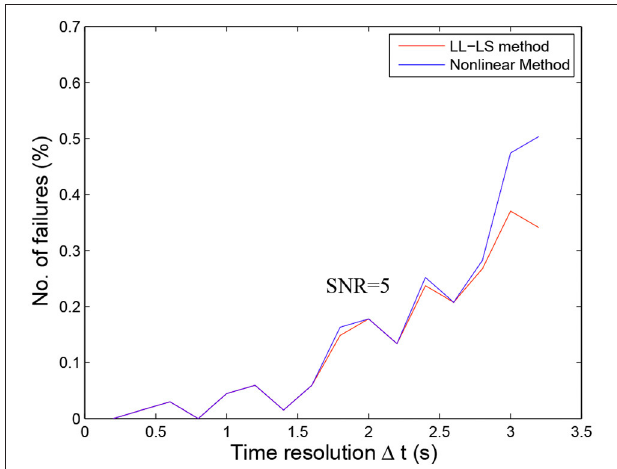
FIGURE 5 | Failures of the fitting procedure with the LL-LS and nonlinear methods as functions of the time resolution ( 1 t ) for SNR 5. The fitting = procedure was considered to have failed if the algorithms did not converge or the calculated values of parameters α and β were imaginary numbers. The α , β estimated parameter obtained using the LL-LS method is used as the { } initial value in the nonlinear fitting procedure. The number of failures of the nonlinear method is thus equal to the number of failures of the LL-LS method plus the number of times that the algorithm for the nonlinear diverged. The number of failures consistently increased as the time resolution decreased. However, there were no failures for the proposed method even for the highest noise